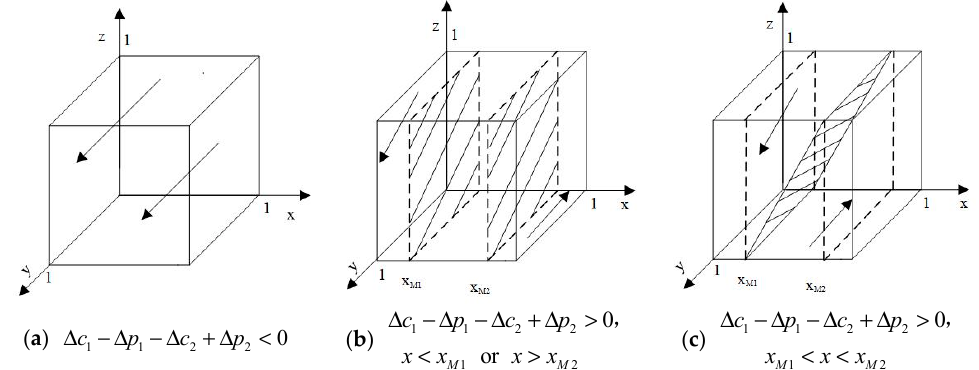
Figure 2. Evolutionary path of manufacturers’ strategy.